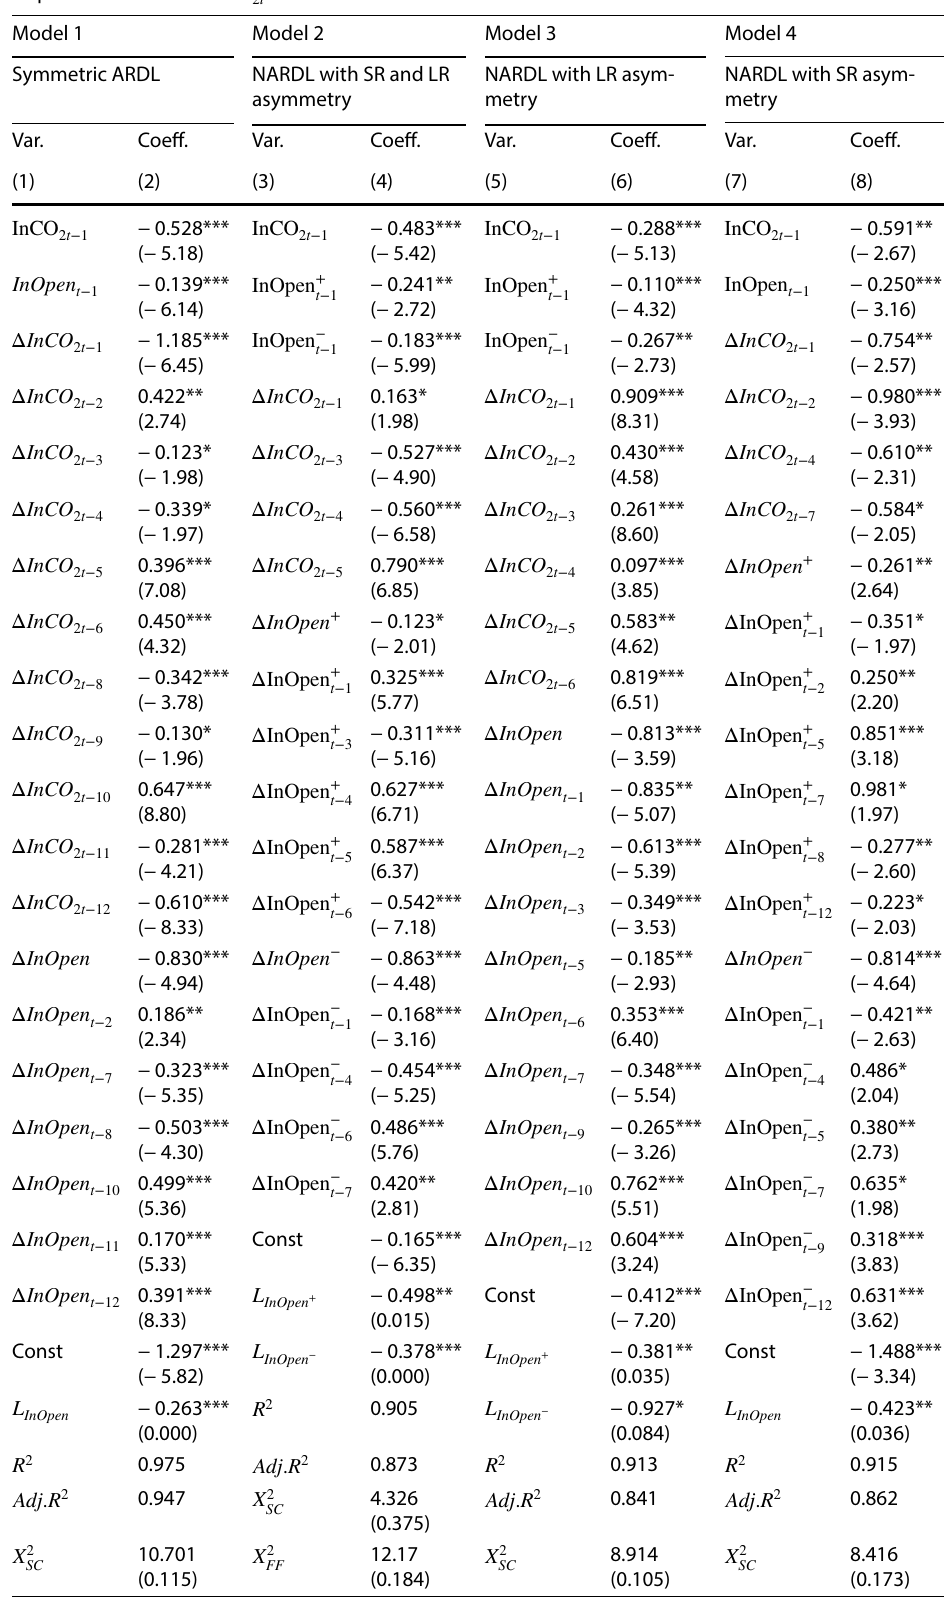
Table 15 Full-information estimates of both symmetric ARDL and nonlinear ARDL (NARDL) models in